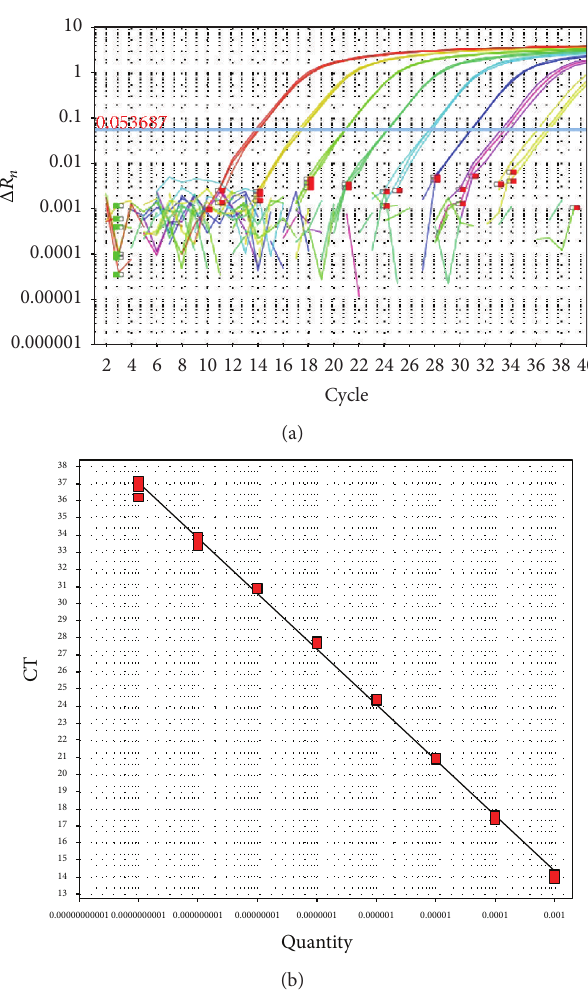
Figure 1: Sensitivity test of TaqMan real-time PCR assay for ten fold serial dilutions of smut pbE DNA standard. (a) The amplification plots showed the testing results of a ten fold dilution serials containing the following pbE DNA: 100pg, 10pg, 1pg, 100fg, 10fg, 1fg, 100 ag, and 10ag, while no amplification signals were observed in the mock and blank controls. (b) The linear regression analyses between the quantities of templates and Ct values. Regression equations were calculated with 𝑦 = −3.247𝑥+4.629 , 𝑅 2 = 0.998, 𝑆 = −3.247 , and 𝐸( % ) = 1.032